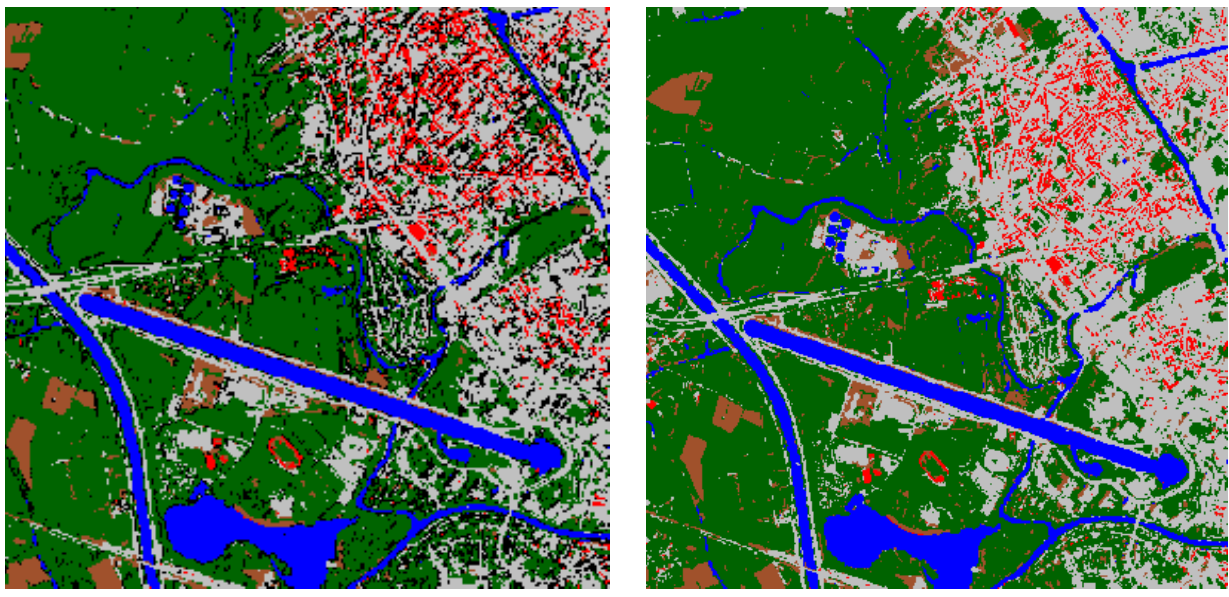
Figure 4. Full hierarchic multi-layer perceptron classification results: original classification (left) and result after post-classification shadow re-assignment (right).